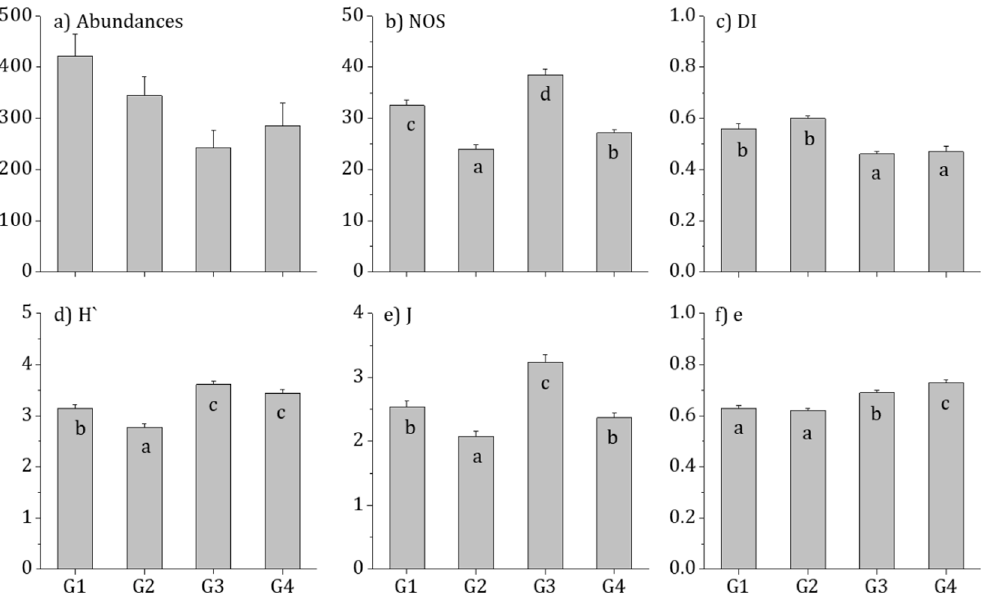
Figure 3. Relative abundances (%) of major epilithic diatom species observed in four groups in Korean estuaries between 2009 and 2016. The dominant species comprise those over the 0.5% of the total abundance in each group.